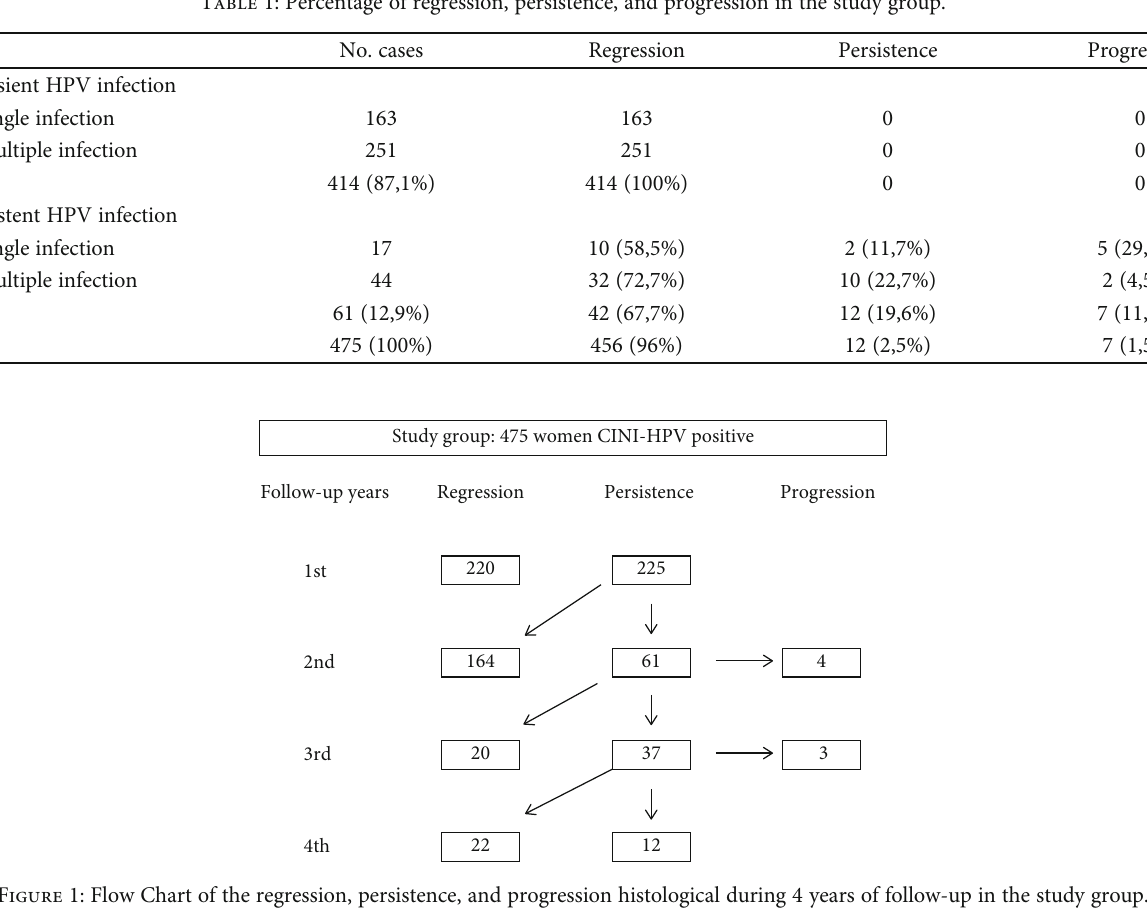
Table 1: Percentage of regression, persistence, and progression in the study group.